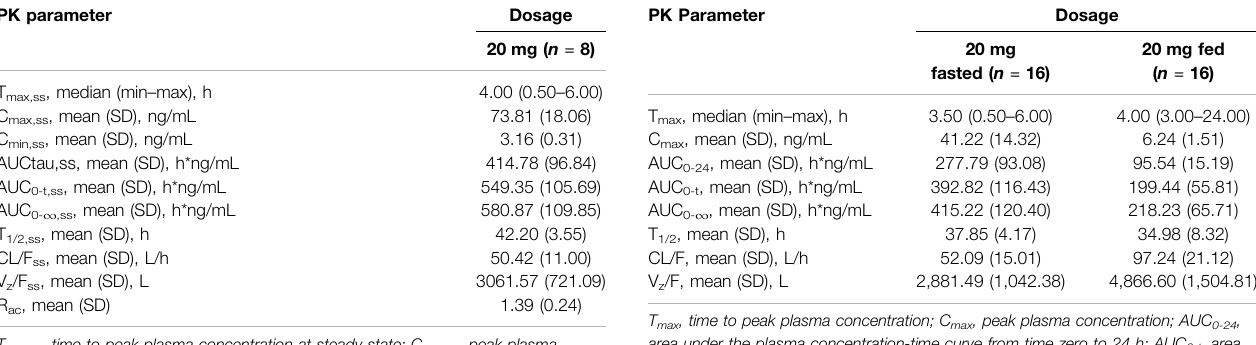
TABLE 5 | Pharmacokinetic (PK) properties of TQ-F3083 after administration of a single dose of 20 mg in the fasted and fed state. PK Parameter